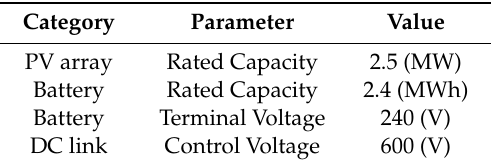
Figure 36. PV battery hybrid system in PSCAD. Table 3. Simulation setting value.